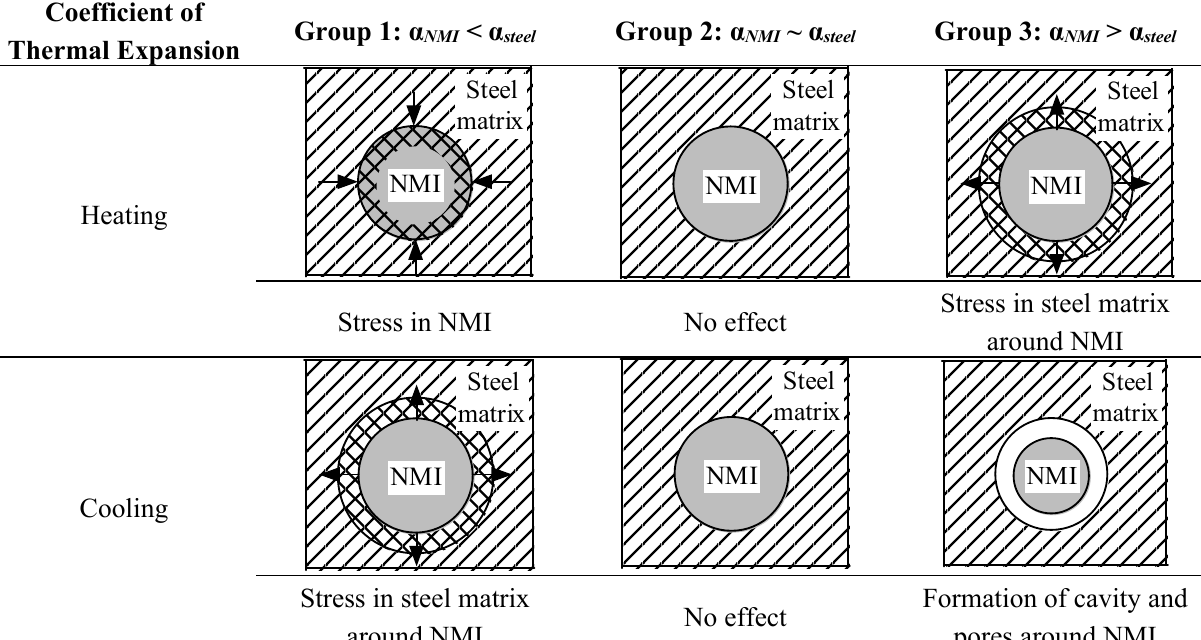
Figure 9. Typical temperature distribution in the cutting zone (in °C) [17]. Table 1. Formation of additional stress fields, cavities and pores around non-metallic inclusions (NMI) and steel matrix due to different thermal expansions during heating and